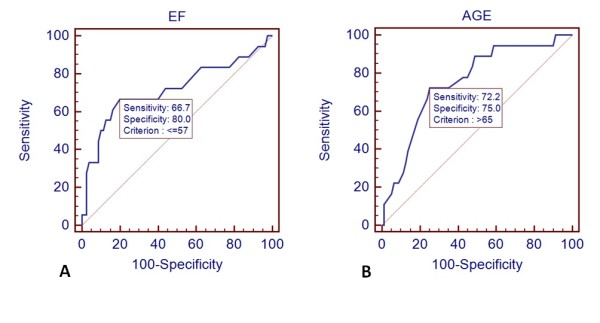
Receiver-operator characteristic analyses to define cut-off values for age (panel A) and ejection fraction-EF (panel B) that are predictors of inadequate response to standard dose adenosine.